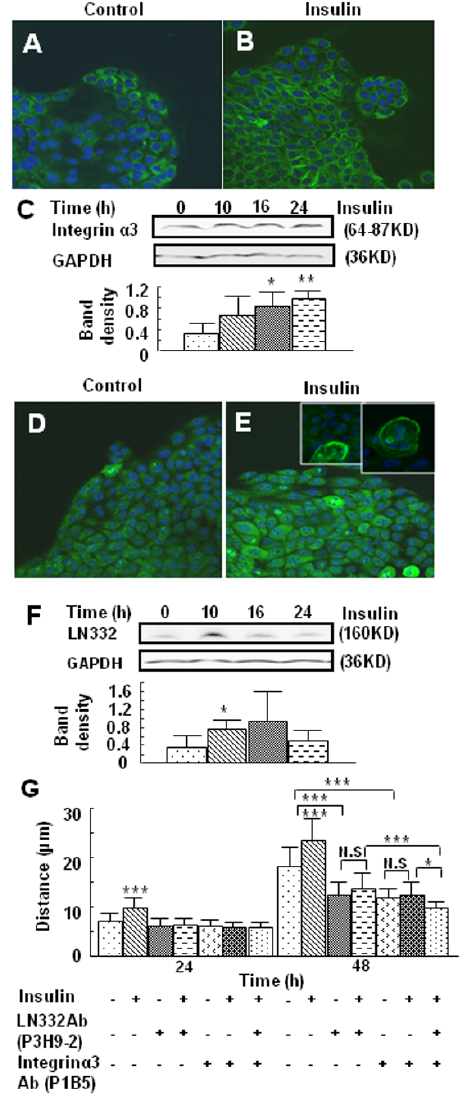
Figure 6 Insulin-induced integrin α 3 and LN332 production contributes to keratinocyte migration . (A, B) Cells seeded in chamber slides were either left untreated or treated with 10 -7 M insulin for 24 h, followed by immunolabeling with the anti- integrin α 3 Ab and FITC-conjugated secondary Ab. (A) , control (B) , insulin treatment 24 h. (C) Non-reducing western blot analysis of integrin α 3 expression shows stimulation of this integrin by insulin in keratinocytes. Results are representative of three independent experiments. Levels of integrin α 3 were quantified by determining the ratio of the integrated density of integrin α 3 to GAPDH loading control using ImageJ software. Data are shown as the mean value +/- SD. *P < 0.05, **P < 0.01 vs control treatment. (D, E) Cells seeded in chamber slides were either left untreated (D) , or treated with 10 -7 M insulin for 24 h (E) , followed by immunolabeling with the anti-LN332 Ab. Small boxes show higher magnification for more detailed distri- bution of the staining. (F) Non-reducing immunoblot analysis of LN332 levels. Insulin stimulates secretion of LN332 by kerati- nocytes. Results are representative of three independent experiments. Levels of LN332 were quantified by determining the ratio of the integrated density LN332 to GAPDH loading control using ImageJ software. Data are shown as the mean value +/- SD. *P < 0.05 vs control treatment. (G) Cells were wounded by scratching and then pre-treated with 25 μ g/ml of function- inhibiting Abs directed against LN332 (P3H9-2) and/or integrin α 3 (P1B5) for 1 h, then treated with 10 -7 M insulin. Migration distances were measured after 24 and 48 h of treatment. *P < 0.05 vs control or as indicated. Insulin induced keratinocyte migration was eliminated by both integrin α 3 and LN332 function-inhibiting Abs. ***P < 0.001 vs control or as indicated. Each treatment group was performed in